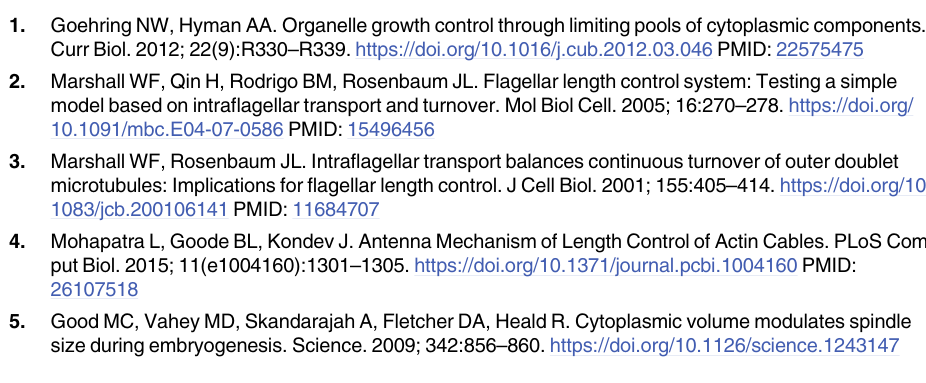
S12 Fig. System size dependent polarity transition in autocatalytic growth of multiple structures. (A-D) We study growth of multiple structures ( M = 4) from a common pool of subunits in a system size V , with size-dependent positive feedback α = − 1, β = 0. This makes the growth process autocatalytic. We see a transition in the size dynamics as we increase the system size V while keeping the subunit density the same. This shows a size dependent polarity establishment process where below a critical size of the system all structures grow and shrink dynamically. But above a critical size, the residence time becomes exceedingly large making transitions virtually impossible in an experimentally relevant timescale. Thus only a stochasti- cally selected structure remain in large size, establishing a polarity in the cell. The pool size N and cell volume V was changed 20%, 30% and 50% in panels B,C and D, respectively. Parame- ters (for panel A): N = 20, V = 1, κ =